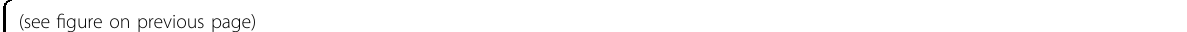
Fig. 5 Physiological effects of lentivirus-mediated GRP78 knockdown in the PVN. Lenti-shGRP78 or Lenti-control viruses were stereotaxically delivered to the PVN of 6-week-old male mice. After surgery and recovery (for 7 days), mice were fed an ND or HFD for 40 days. Body weight and food intake were measured daily at 5:00 p.m. Before killing, oxygen consumption (for 24 h) and locomotor activity (for 1 h) were measured. a Schematic of the lentiviral vector-encoding GRP78 short hairpin RNA (top), and the injection sites in the PVN shown in a coronal diagram of the brain (bottom) (scale bar, 100 µm). Real-time PCR analysis of GRP78 mRNA in the PVN. Changes in b body weight, c food intake, d oxygen consumption, and e locomotor activity in mice fed an ND or HFD. One-tailed Student ’ s t test for a : n = 3 per group, ** P < 0.01 versus Lenti-control. Two-way ANOVA, Bonferroni post hoc tests for b – e : n = 3 – 4, # P < 0.05, ## P < 0.01, ### P < 0.001 versus ND, * P < 0.01 versus Lenti-control. The data